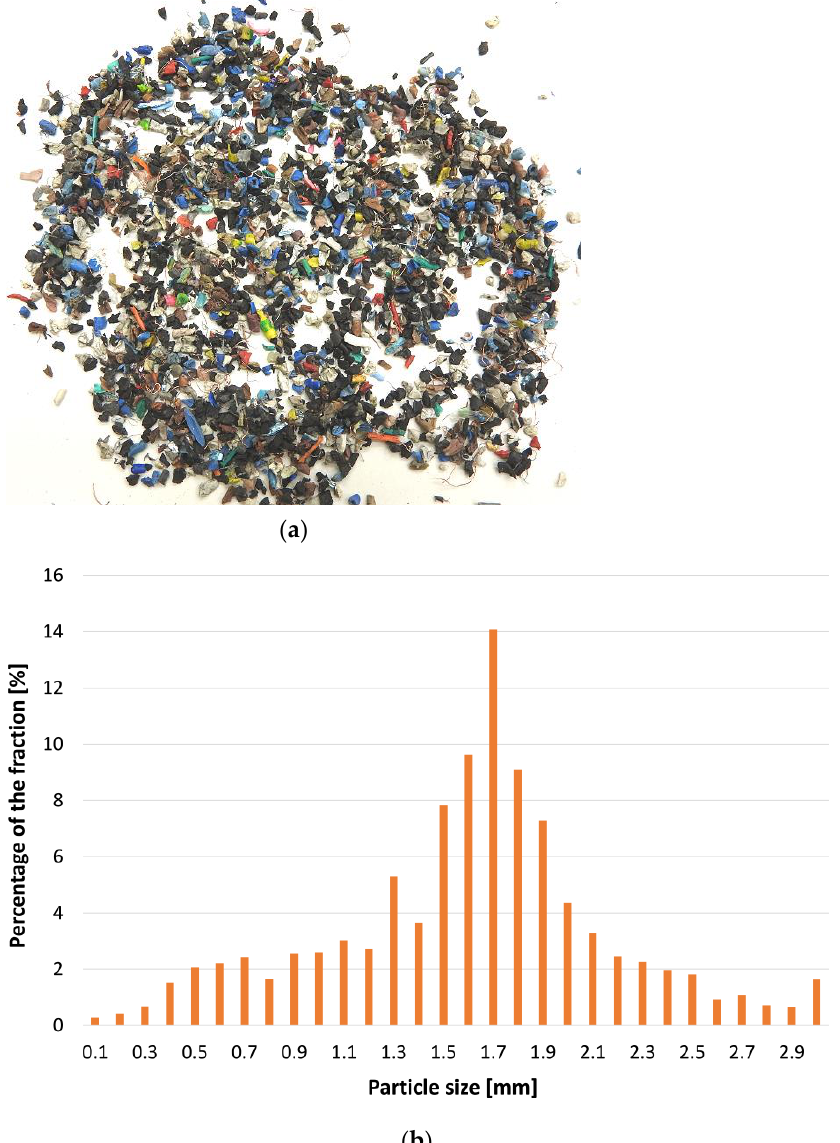
Figure 2. ( a ) Input material ( “ speck ” ) to the moulding process, obtained in the shredding process. ( b ) Percentage distribution size of the fractions by particle size.